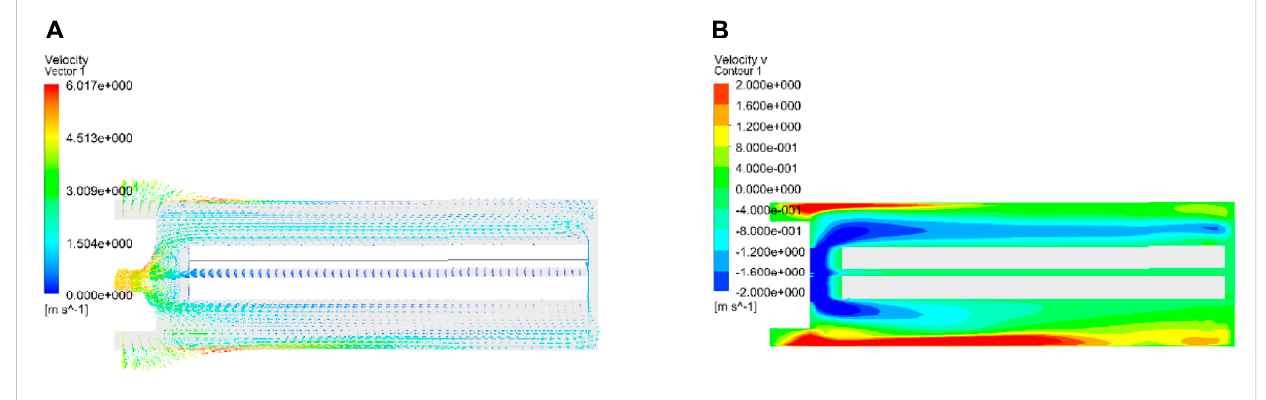
FIGURE 6 Instantaneous velocity vector fi eld (A) and velocity contour plot of the u y component (B) for Plane 1 at 2,400 s.